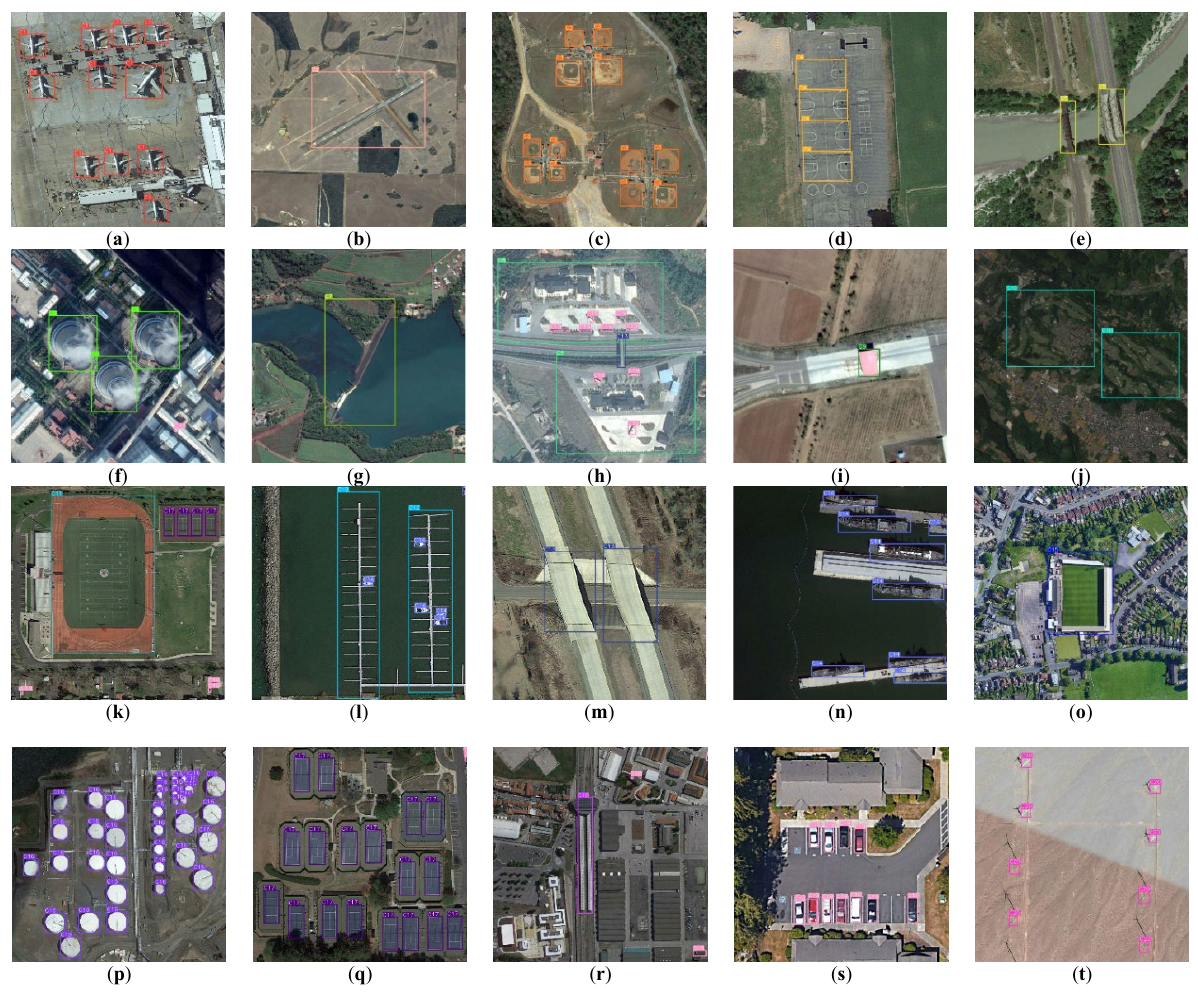
Figure 10. Detection results of various categories of the proposed HADU-YOLO on the DIOR test set. ( a ) airplane; ( b ) airport; ( c ) baseball field; ( d ) basketball court; ( e ) bridge; ( f ) chimney; ( g ) dam; ( h ) expressway service area; ( i ) expressway toll station; ( j ) golf field; ( k ) ground track field; ( l ) harbor; ( m ) over-pass; ( n ) ship; ( o ) stadium; ( p ) storage tank; ( q )tennis court; ( r ) train station; ( s ) vehicle; ( t ) windmill.